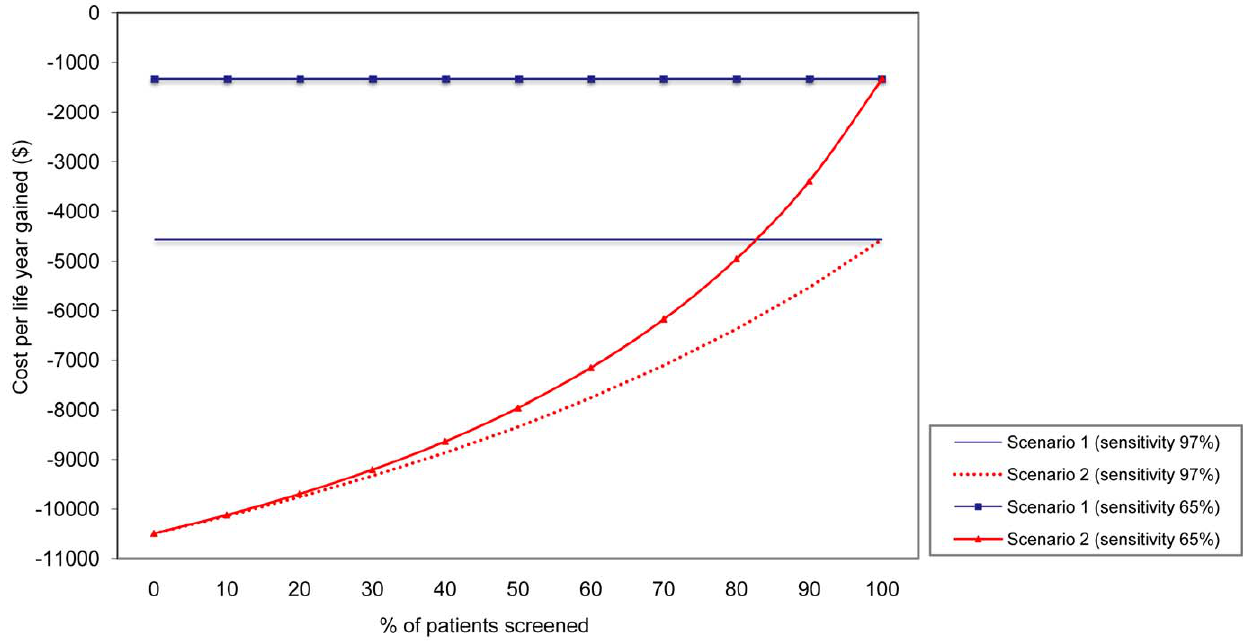
Figure 2. Effect of suboptimal adherence to preoperative S.aureus screening and test sensitivity on cost per life year gained (discounted) per 1000 patients for different screening scenarios. Scenario 1 is treatment of S. aureus carriers identified by screening; scenario 2 is treatment of S. aureus carriers identified by screening plus treatment of all patients that were not screened. In scenario 1 the life years gained and costs increase, ordecrease, at a constantrateresultinginaninvariable costper lifeyears gained.Notethe negative costs onthe y-axis representingcost-savings.